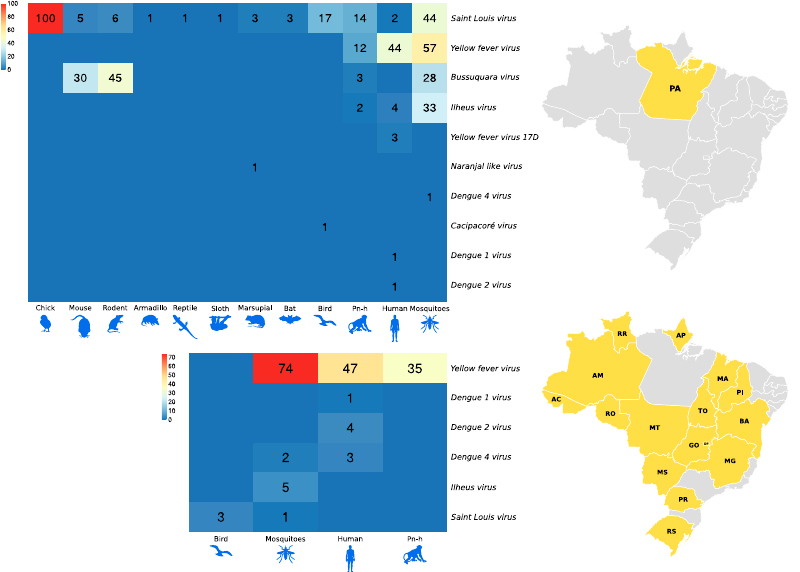
Figure 6. Distribution of flavivirus isolates in mice according to the animal model of origin. The larger heatmap is associated with isolates in the state of Pará. The smaller heatmap is associated with isolates from other Brazilian states.